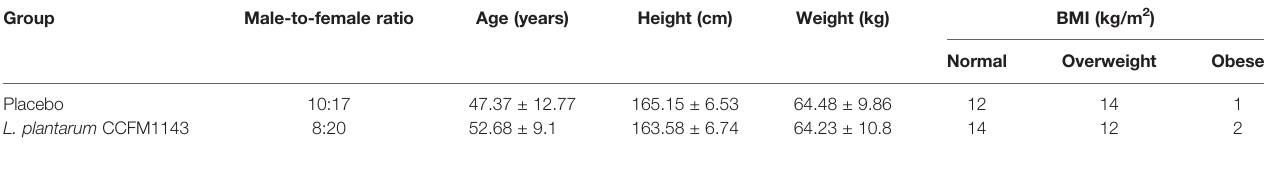
TABLE 2 | Basic characteristics of patients with diarrhea. Group